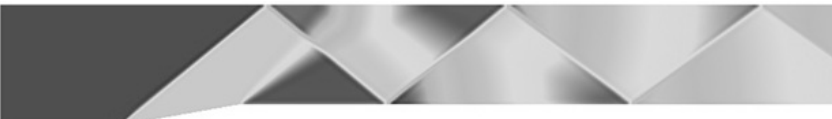
Figure 4. Adding new nodes at the center of faces and at the midpoint of edges: ( a ) a hexahedral cell, ( b ) a cell in the form of an arbitrary polyhedron.